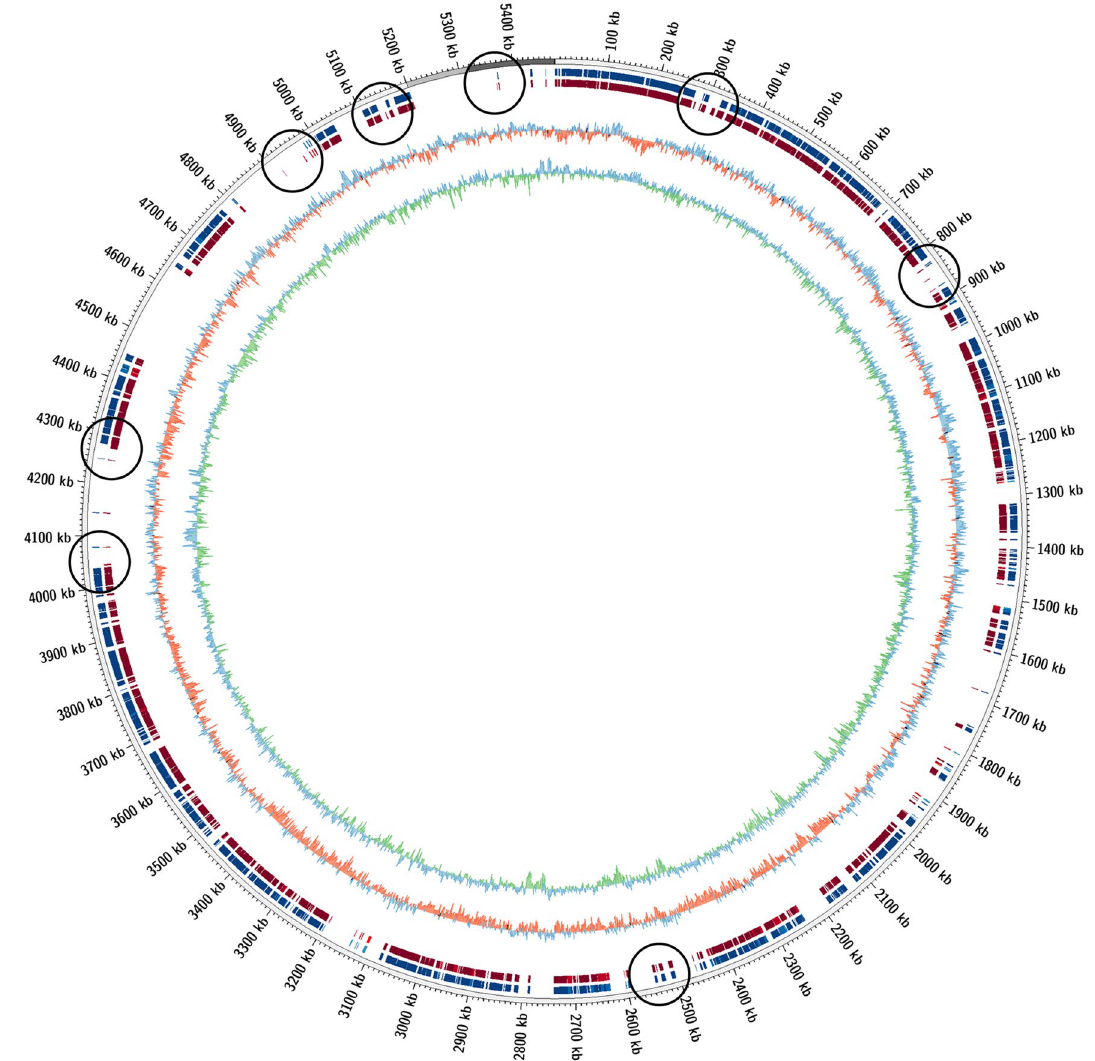
Figure 4. mummer2circos alignment of hybrid_5 (red) and HiSeq_31 (blue) to the Octadecabacter arcticus genome (grey). Center plots are GC skew (blue/red) and GC content/variation (blue/green). Areas where Hybrid_5 covers more of the O. Arcticus genome are circled in